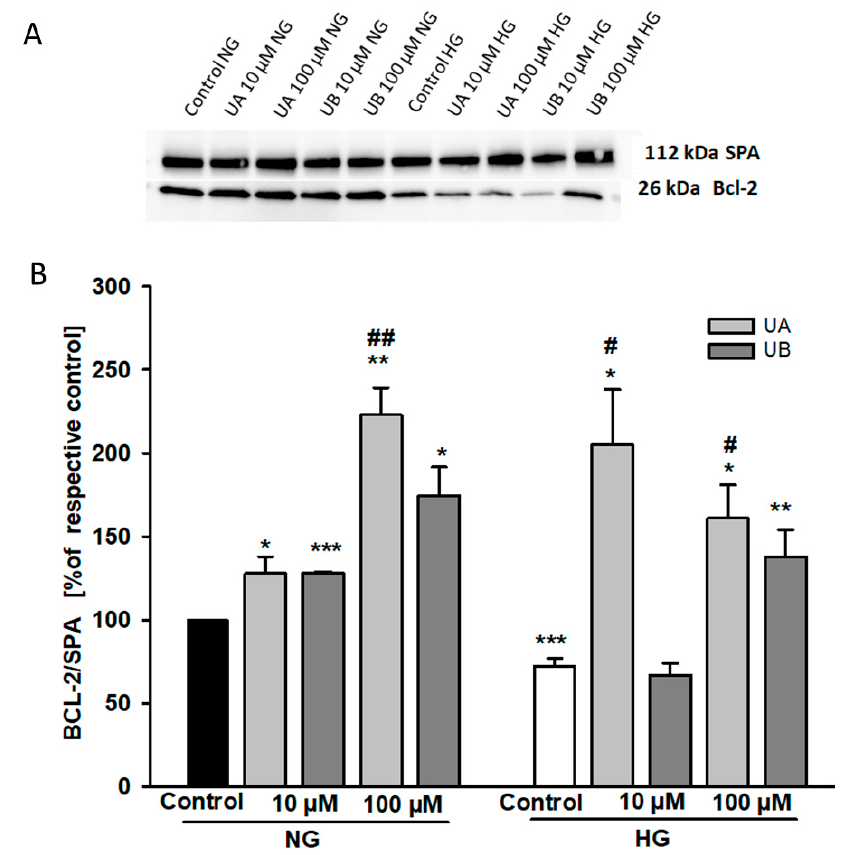
Figure 6. Urolithins and high glucose modulate the expression of Bcl-2. Podocytes cultured for 7 d in normal (5.5 mM, NG) or high (25 mM, HG) glucose were incubated for 24 h with 10 µ M UA and 10 µ M UB. 20- µ g protein samples from total cell lysates were subjected to Western blot analysis followed by quantitative densitometric analysis. Representative immunoblot ( A ). Quantification results of the ratio of Bcl-2 to Alpha 1 Sodium Potassium ATPase (SPA) are shown as % of respective Control ( B ). HG Control is expressed as % of the NG Control. Results show mean ± SEM. ANOVA and the Student’s t -tests were used to calculate p values. * p < 0.05 vs. respective Control, ** p < 0.02 vs. respective Control, *** p < 0.001 vs. NG Control, # p < 0.05 vs. HG-UB10 mM, ## p < 0.02 vs. NG-10 µM UA ( n = 4).